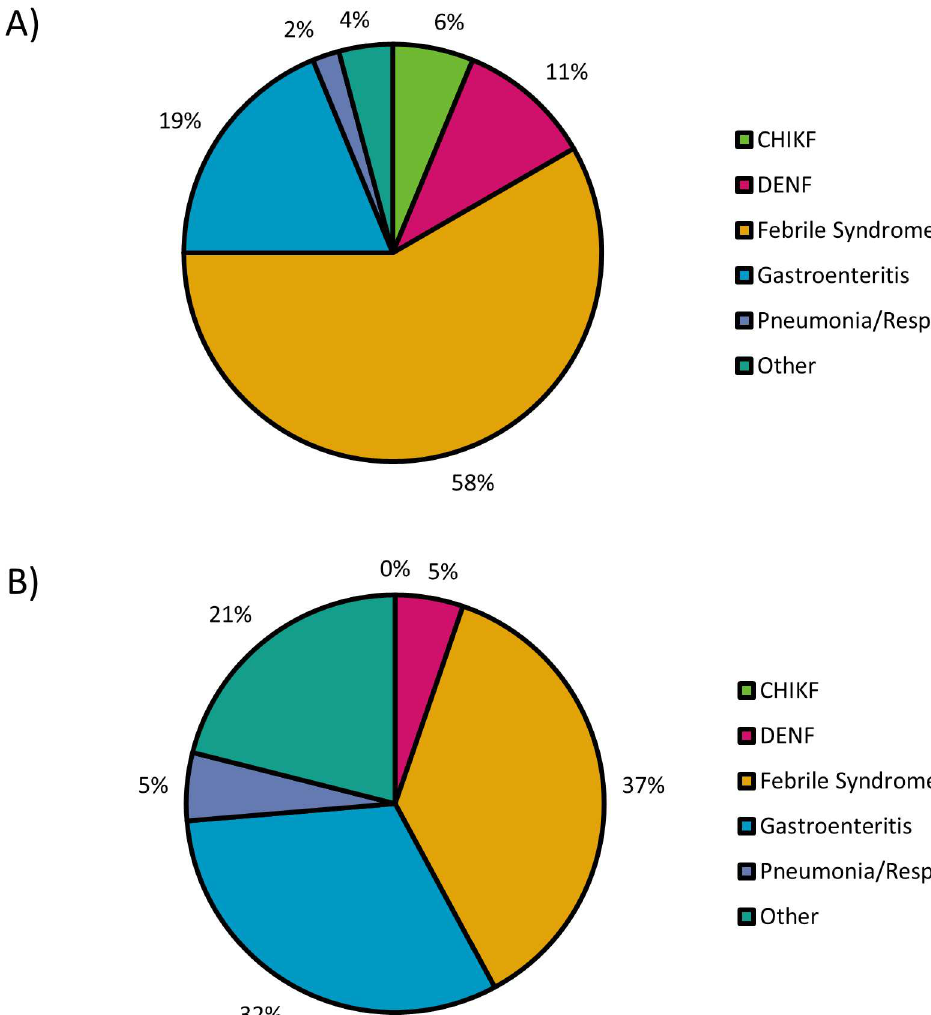
Fig 4. Clinical diagnoses made for CHIKF-positive and CHIKF-negative patients. Serum from patients visiting an emergency clinic in the DR was tested for CHIKV RNA and IgM, and results were retrospectively matched to initial diagnoses basedon clinical presentation. The most common diagnosis for patients in both groupswas undifferentiated febrile illness. Most notably, while CHIKF-positive (RNA-positive) patients (A) were more likely to be diagnosedwith somethingother than CHIKF, no CHIKF-negative (RNA and IgM negative)patients (B) were misdiagnosed with